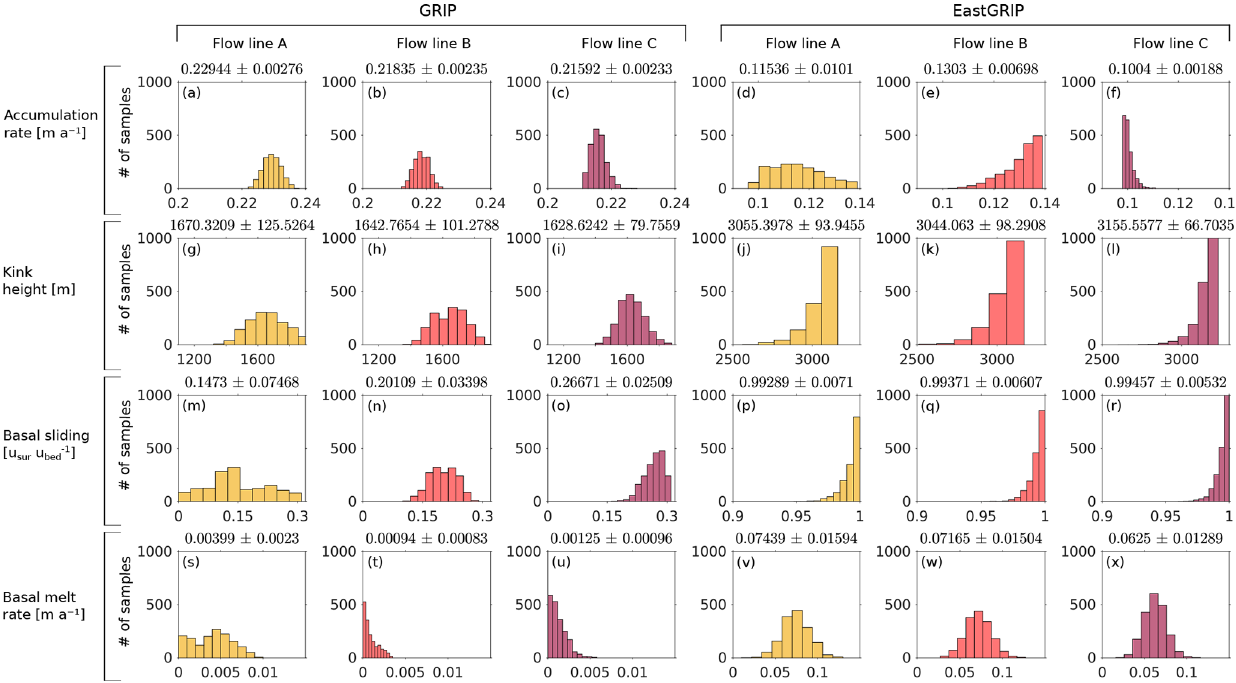
Figure 6. Histograms of the model parameters accumulation rate, basal melt rate, kink height and basal sliding at GRIP and EastGRIP for each flow line. The corresponding means and standard deviations are displayed on top of the